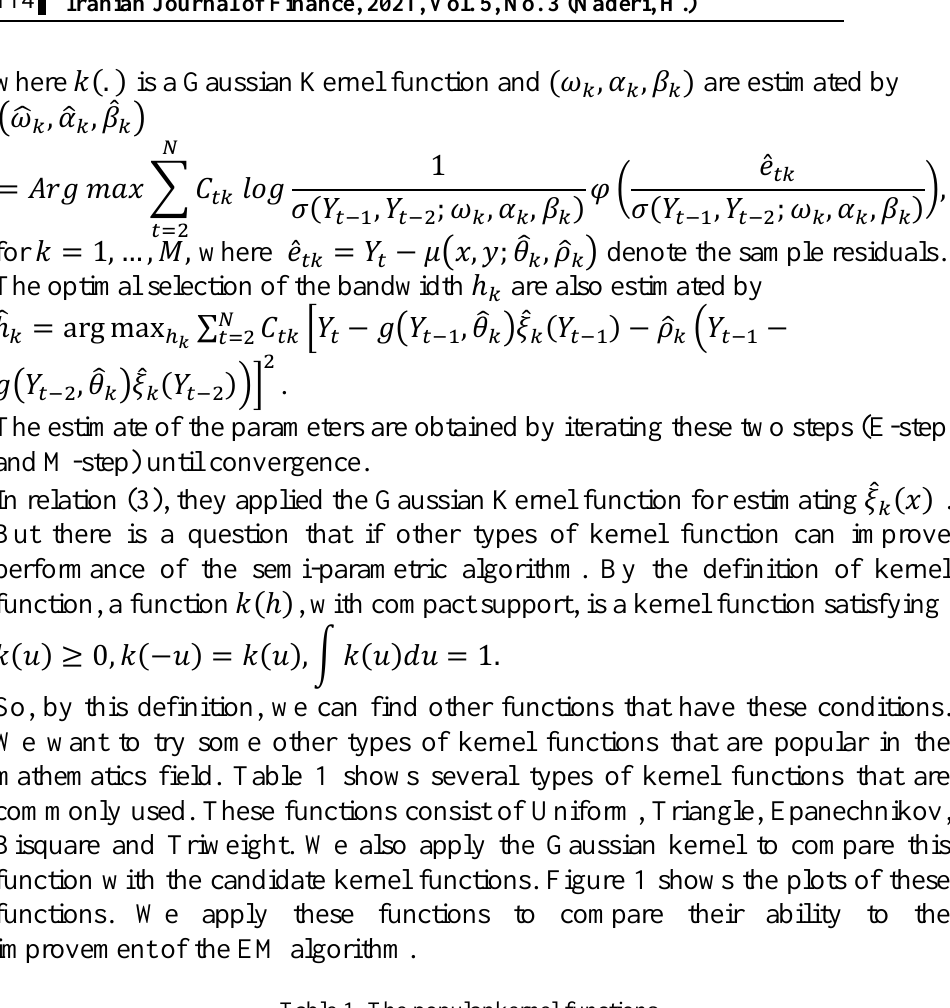
Table 1. The popular kernel